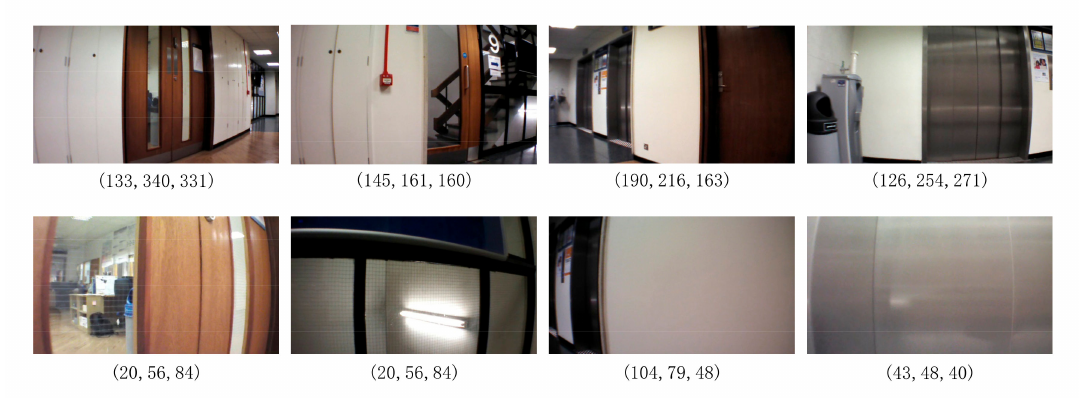
Figure 6. Training data set.